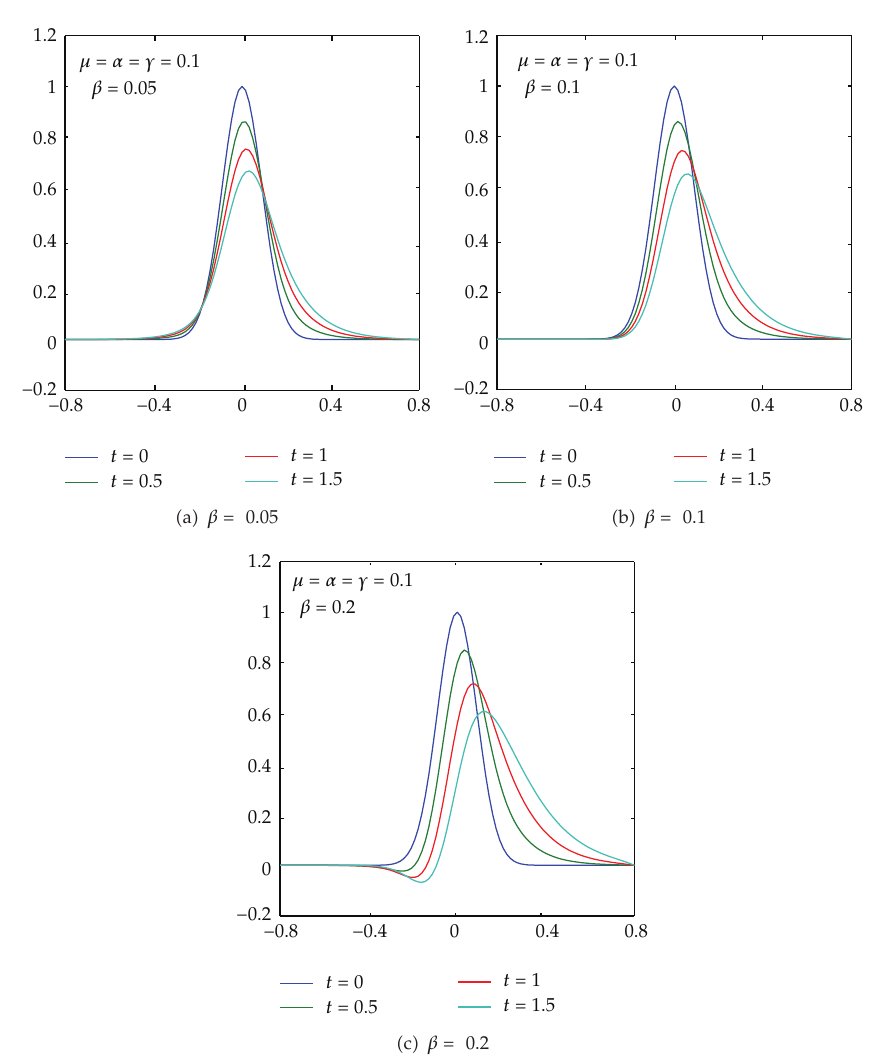
Figure 2: The evolution of u (cid:2) x,t (cid:3) with di ff erent β